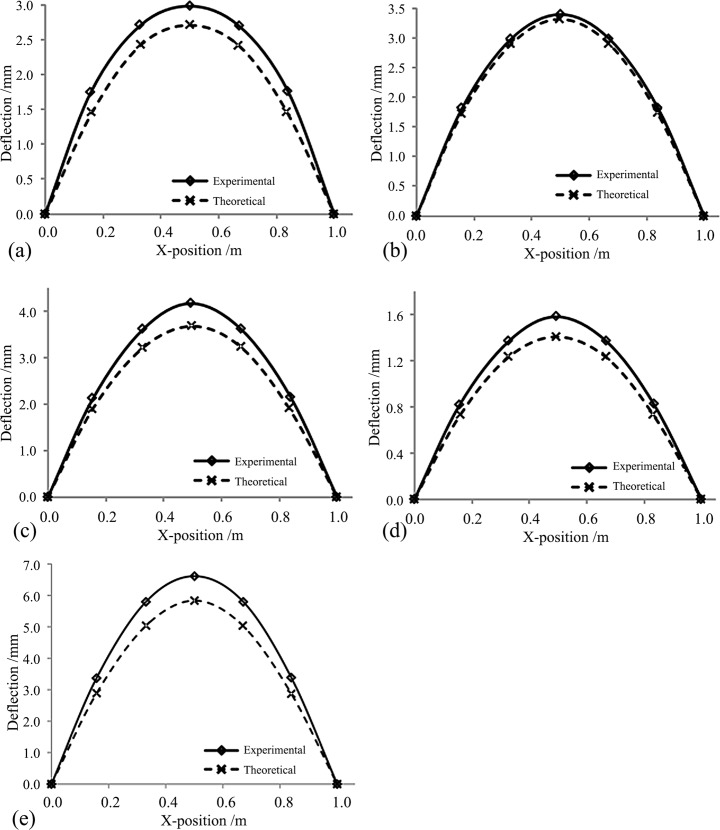
Calculation of specimen deflections and comparison with the experimental values.(a) SX75-75 deflection. (b) SX75-125 deflection. (c) SX75-175 deflection. (d) SX100-75 deflection. (e) SX50-75 deflection.